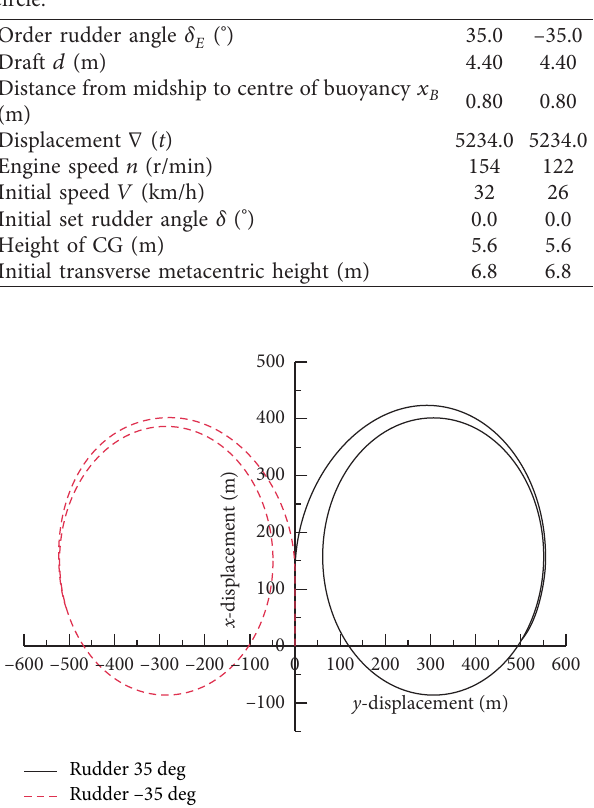
Figure 6: Rotation trajectory for a rudder angle of approximately 35 ° (main engine speed of 154r/min).